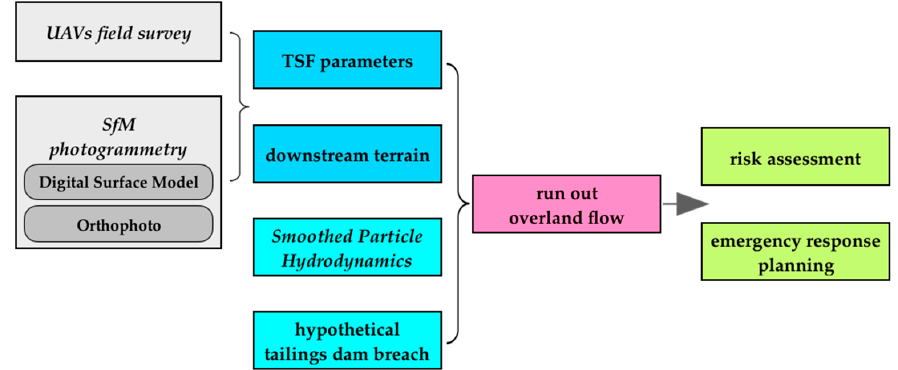
Figure 1. Flowchart of the proposed procedure for modelling the run-out flow of tailings dam breach.